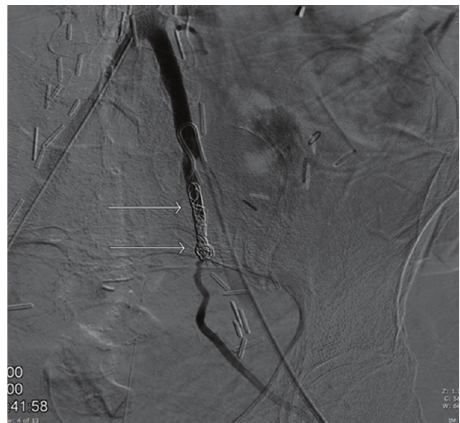
Figure 3: Four platinum coils were used to embolize the left proximal internal iliac artery (white